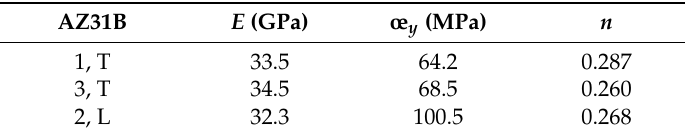
Table 2. Uniaxial compression experimental data of magnesium alloy AZ31B.